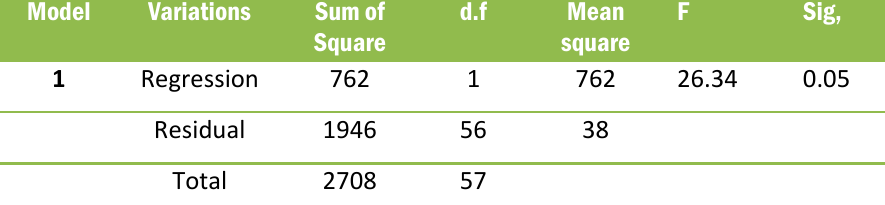
Table 7: Summary of Analysis of Variance for public service ethos